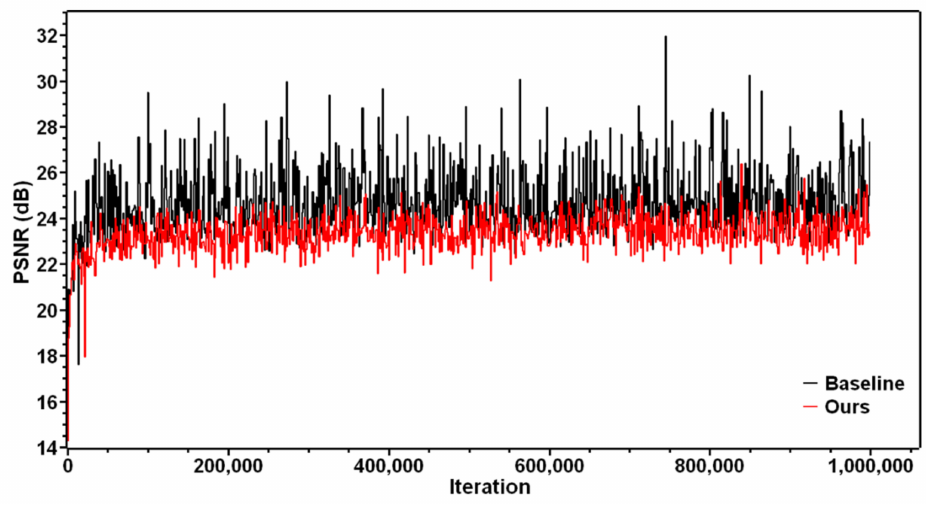
Figure 6. PSNR values in the pretraining networks. Baseline: pre-ESRGAN, the pretrain for ESRGAN; ours: